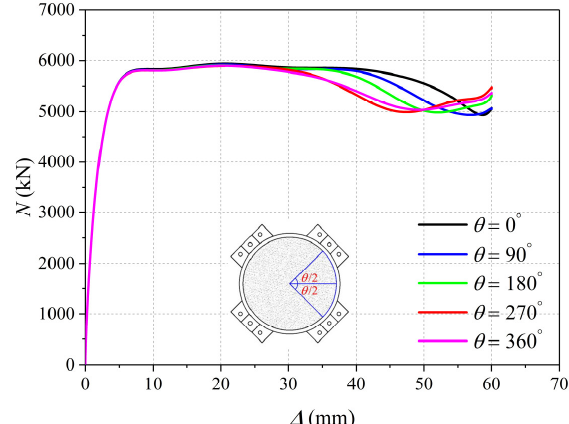
Figure 23. N - ∆ curves of BWCFST short columns with different θ Figure 23. N -  curves of BWCFST short columns with different  .